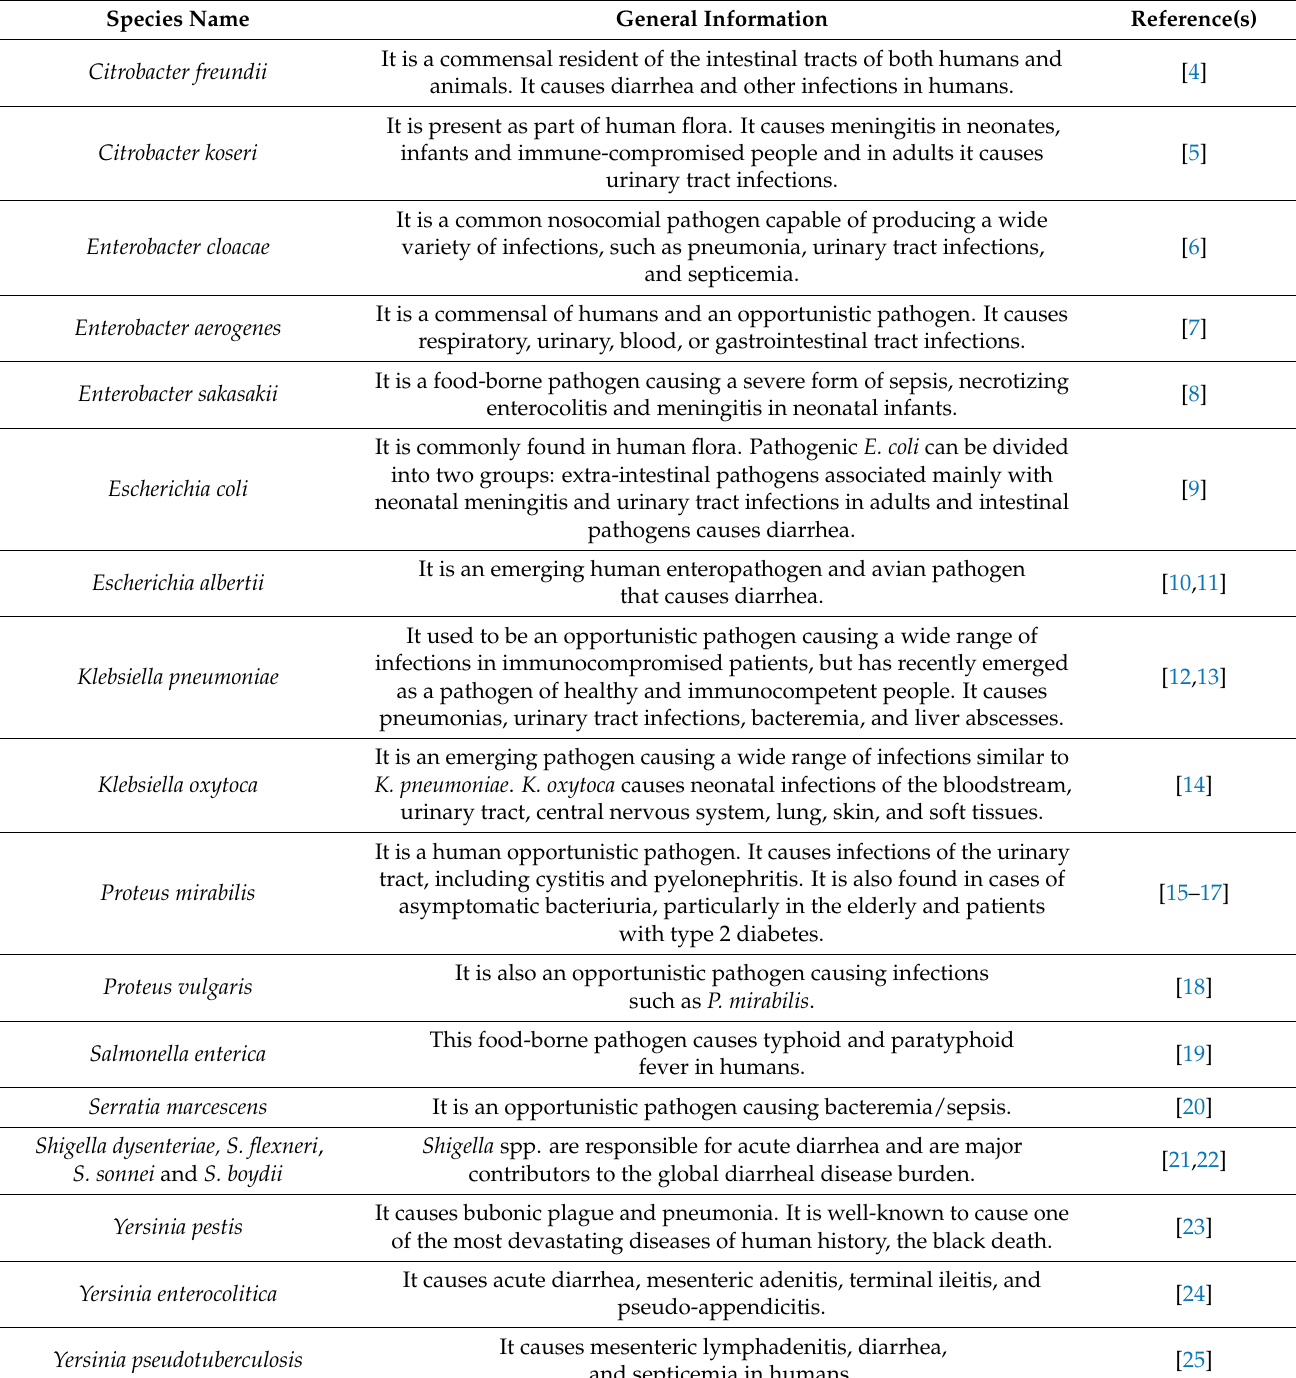
Table 1. Information on well-known pathogens of the bacterial class Gammaproteobacteria